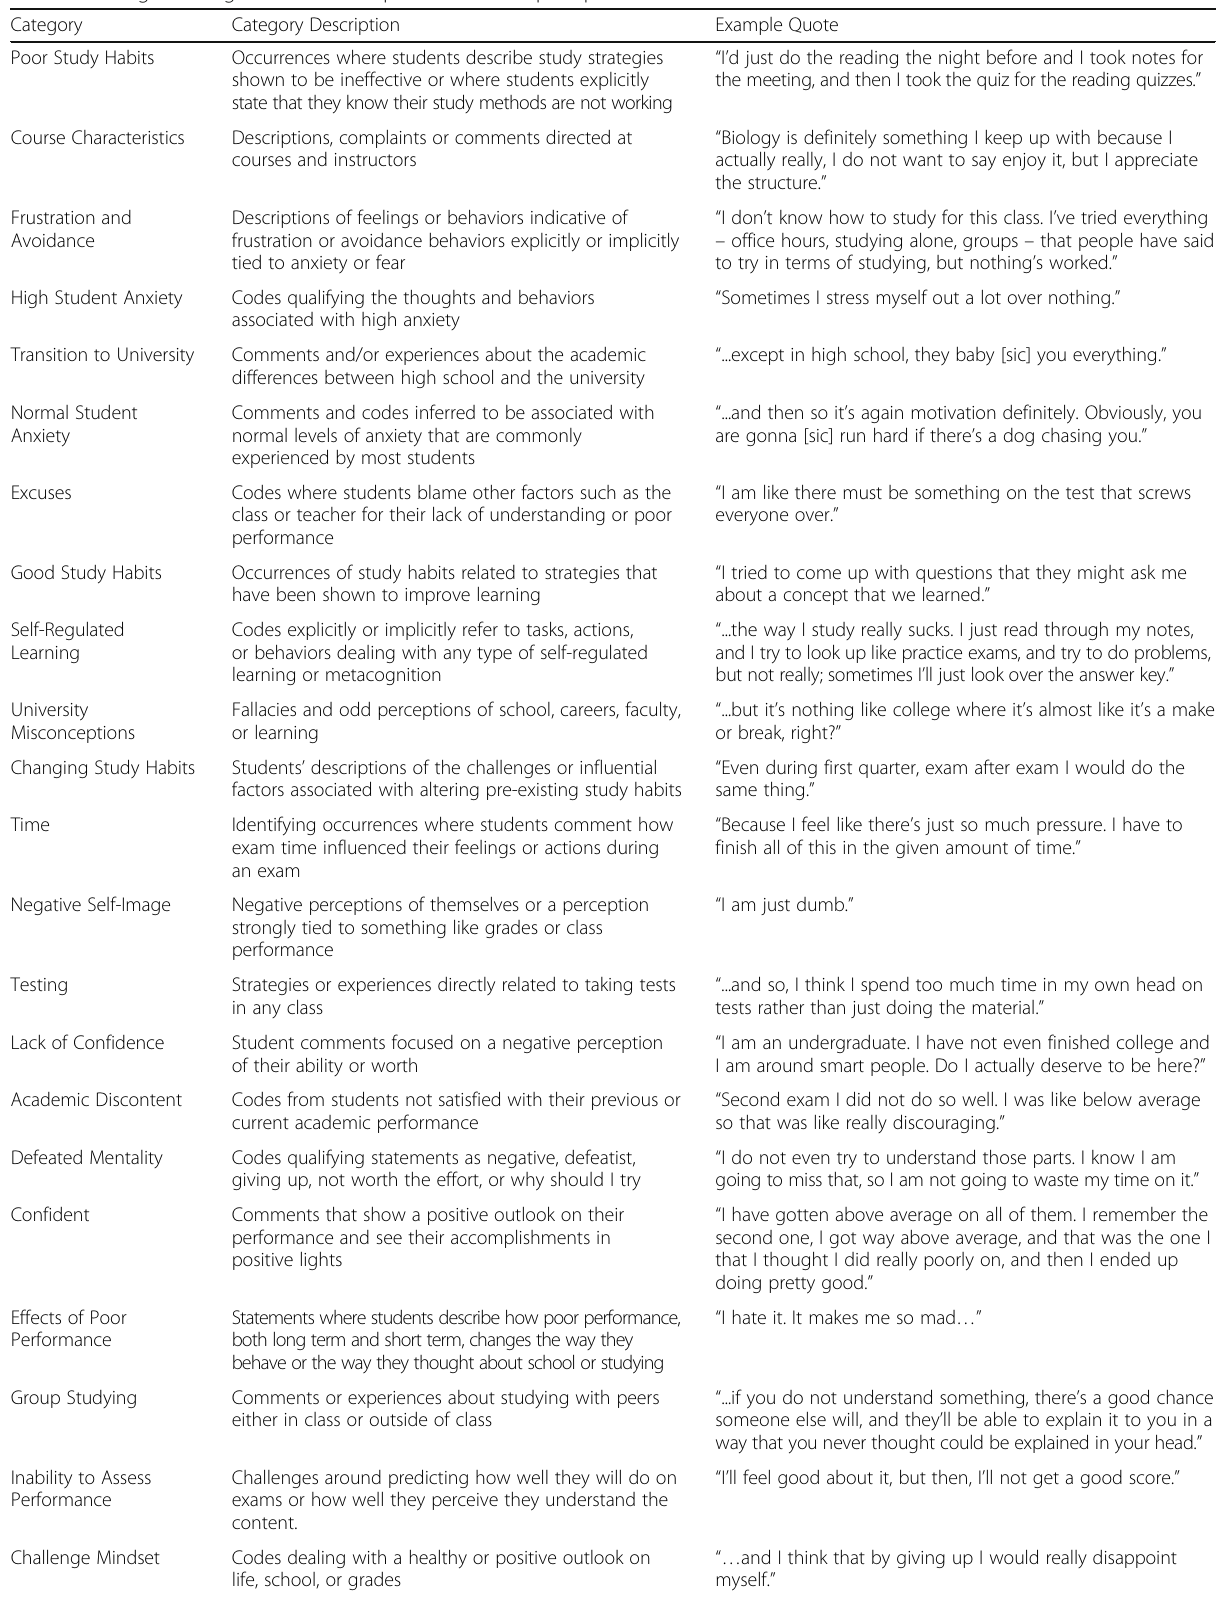
Table 2 Emergent categories with descriptions and exemplar